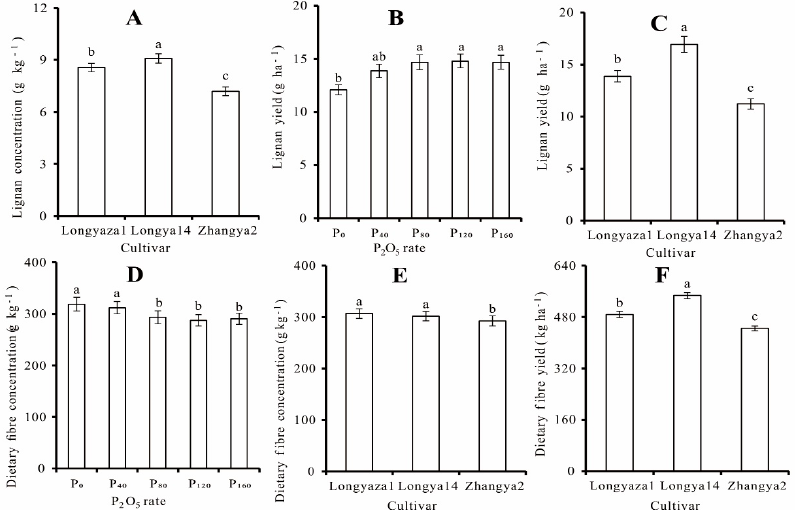
Figure 3. Effects of ( A ) cultivar on lignan concentration, ( B ) phosphorus level on lignan yield, ( C ) cultivar on lignan yield, ( D ) phosphorus level on dietary fiber concentration, and ( E ) cultivar on dietary fiber concentration and ( F ) yield. Error bars are standard errors of the means ( n = 15). Di ff erent letters indicate means that are signi fi cantly di ff erent at P < 0.05 according to the Tukey test.